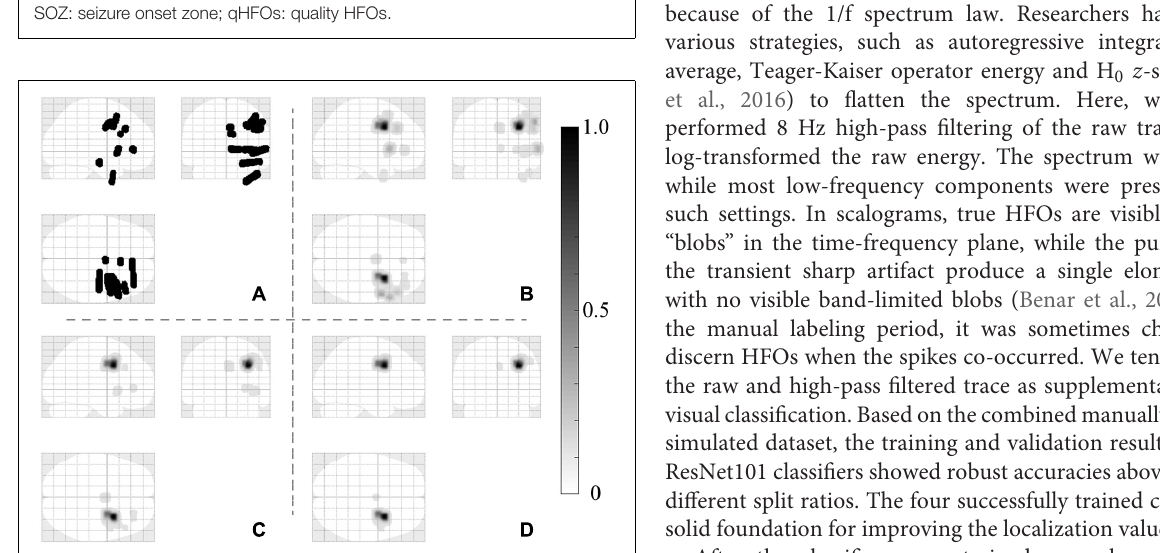
FIGURE 4 | Percentage of qHFOs with FR inside and out of SOZ. The percentage of qHFOs with FR was significantly higher inside SOZ than outside ( p = 0.0005, paired t -test). HFOs: high-frequency oscillations; FR: fast ripple; SOZ: seizure onset zone; qHFOs: quality HFOs.